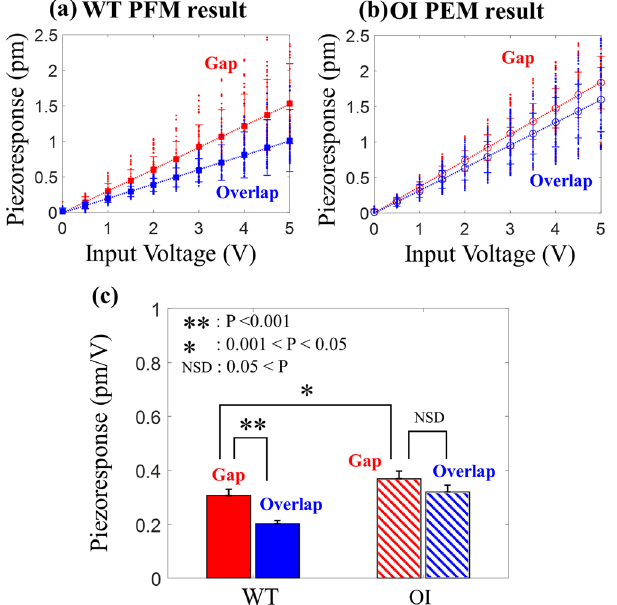
Fig. 3 Comparison of piezoresponse measured at the gap and overlap regions of WT and OI collagens. The PFM result of point measurements at the gap (red) and overlap (blue) regions of a WT and b OI collagen. The cantilever tip was precisely located at the gap and overlap regions and AC voltage was applied ranging from 0 V to 5 V. The red and blue lines indicate the average piezoresponse of fi ve fi brils at the gap and overlap regions in both WT and OI collagen. c One-way ANOVA with a post-hoc Tukey HSD test was used to determine the statistically signi fi cant differences between the piezoresponse at the gap (0.31 ± 0.02 pm/V) and overlap (0.20 ± 0.01 pm/V) regions in WT collagen and at the gap (0.37 ± 0.03 pm/V) and overlap (0.32 ± 0.03 pm/V) regions in OI collagen. The signi fi cance was set at 0.001 < p -value < 0.05 (*) and p -value < 0.001